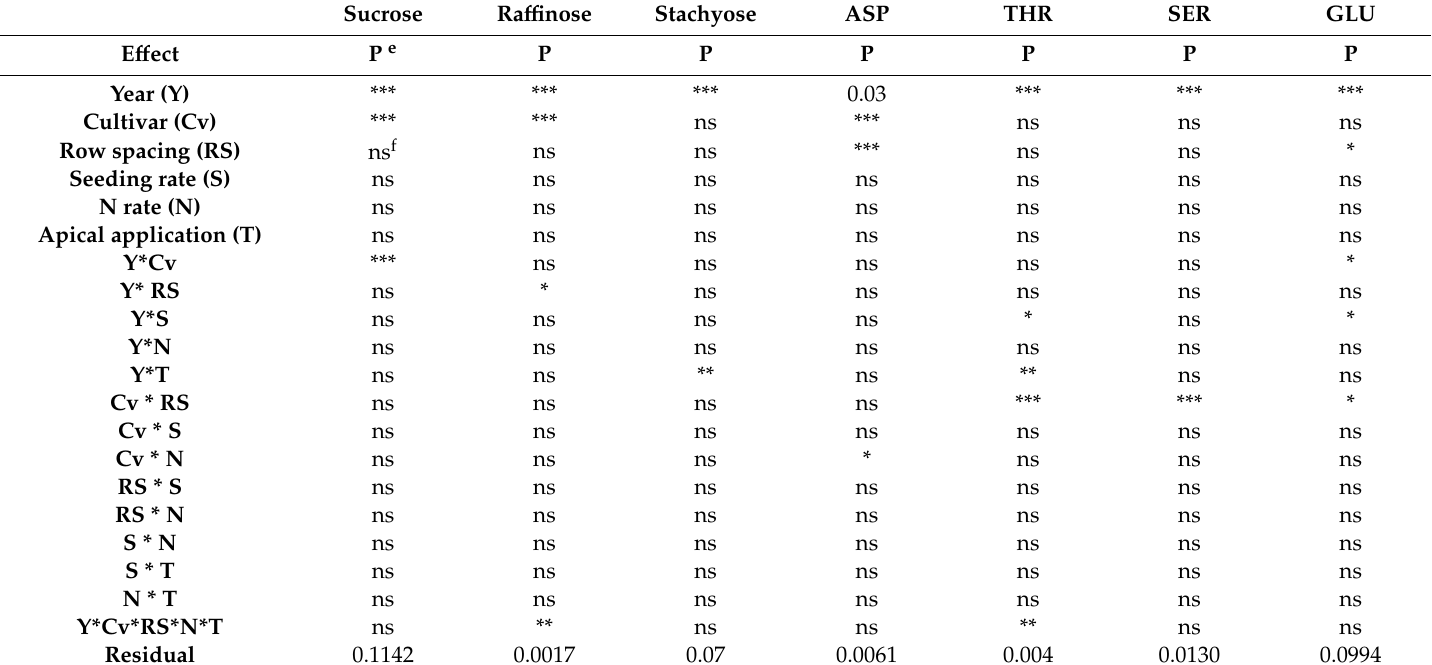
Table 2. Analysis of variance (P values) for the e ff ect of main e ff ects of year (Y), cultivar (Cv), row spacing (RS), seeding rate (S), nitrogen rate (N), apical application (T), and their interactions on seed sugars (sucrose, ra ffi nose, stachyose (%), and amino acids aspartic acid (ASP), threonine (THR), serine (SER), and glutamic (GLU) (%). The experiments were conducted in 2015 and